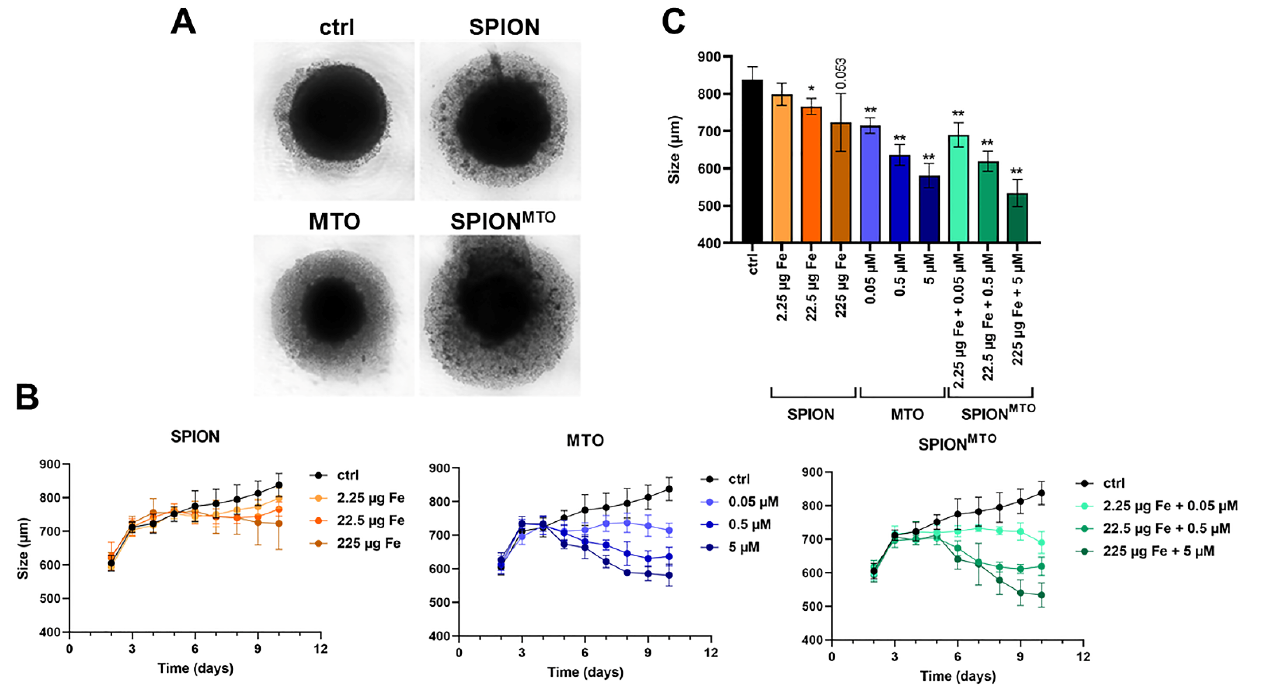
Figure 2. Impact of free and nanoparticle-bound MTO on the growth of spheroids. Spheroids were cultured from A375M and fibroblasts. After 72 h, free MTO, SPION MTO or unloaded SPIONs were added. ( A ) Transmission microscopy of spheroids on day 10. ( B ) The growth of the spheroids was observed with IncuCyte, and analyzed with ImageJ over 10 days. ( C ) Comparison of spheroid sizes on day 10. The experiment was performed in quadruplicates. The mean values with standard deviations are shown. Significances (treatment versus control) were calculated using one-way ANOVA, with * p ≤ 0.05, ** p ≤ 0.01 ( B